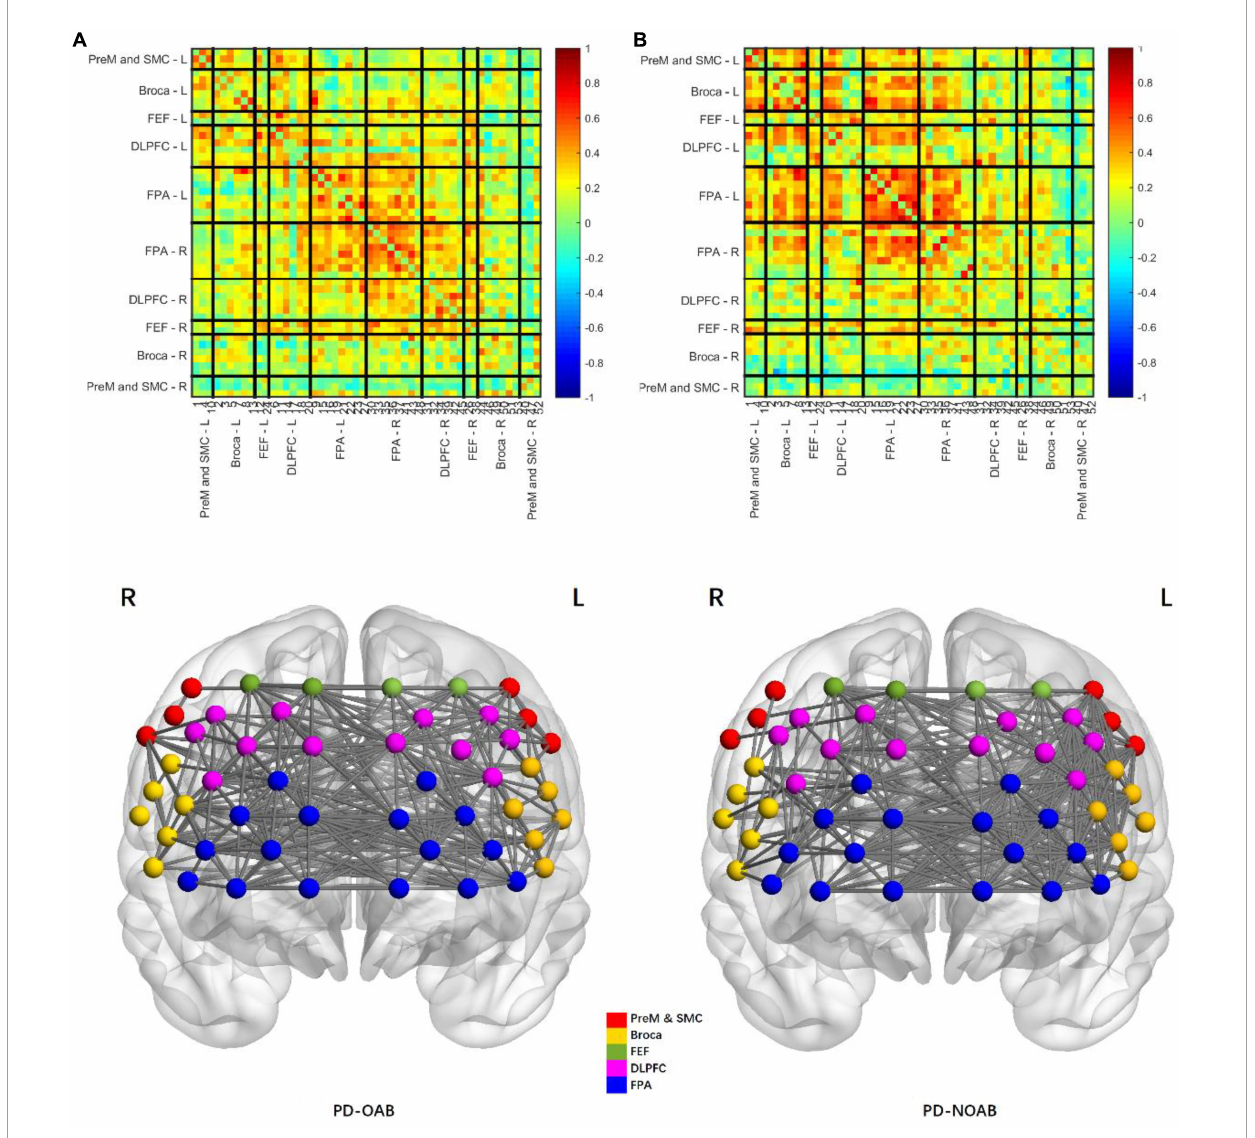
FIGURE4 Pattern of resting-state functional connectivity strength between the regions of interest of PD-OAB (A) and PD-NOAB (B)